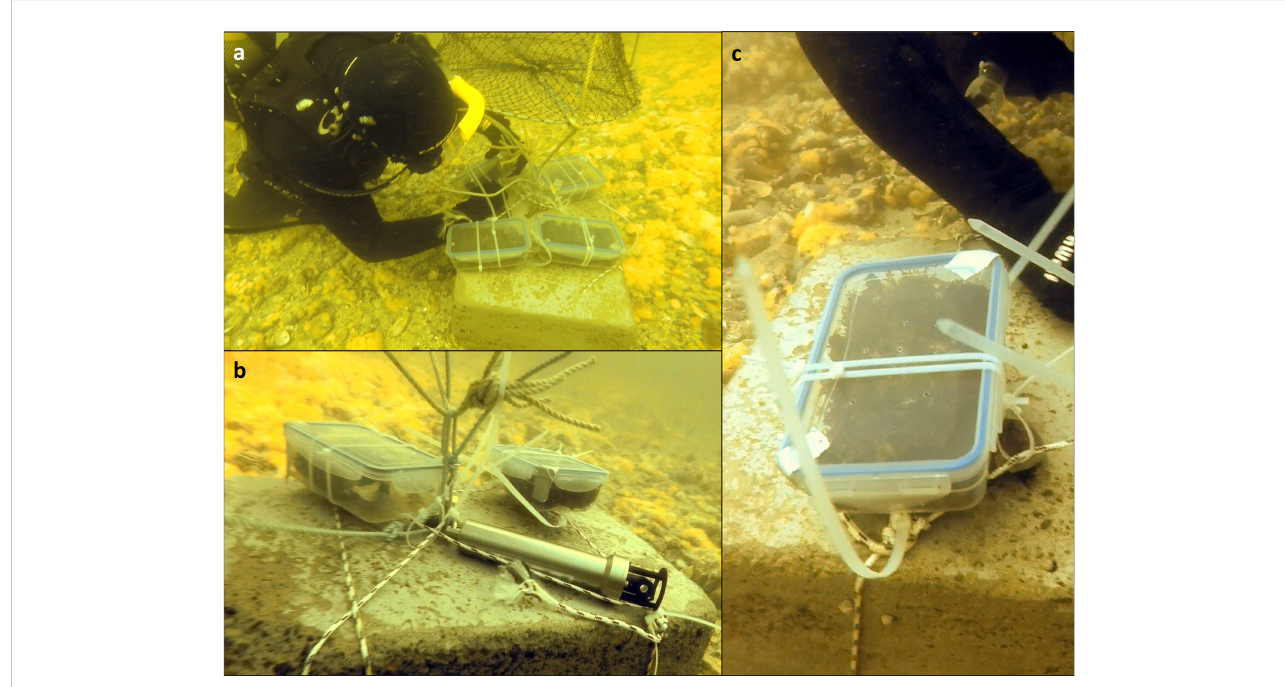
FIGURE 1 Transplantation devices consisting in plastic containers with one hundred perforations and macroalgae biomass placed inside (A, C) . Boxes were anchored with cable ties to arti fi cial concrete reefs and accompanied with a continuous conductivity and temperature (CT) meter (B)